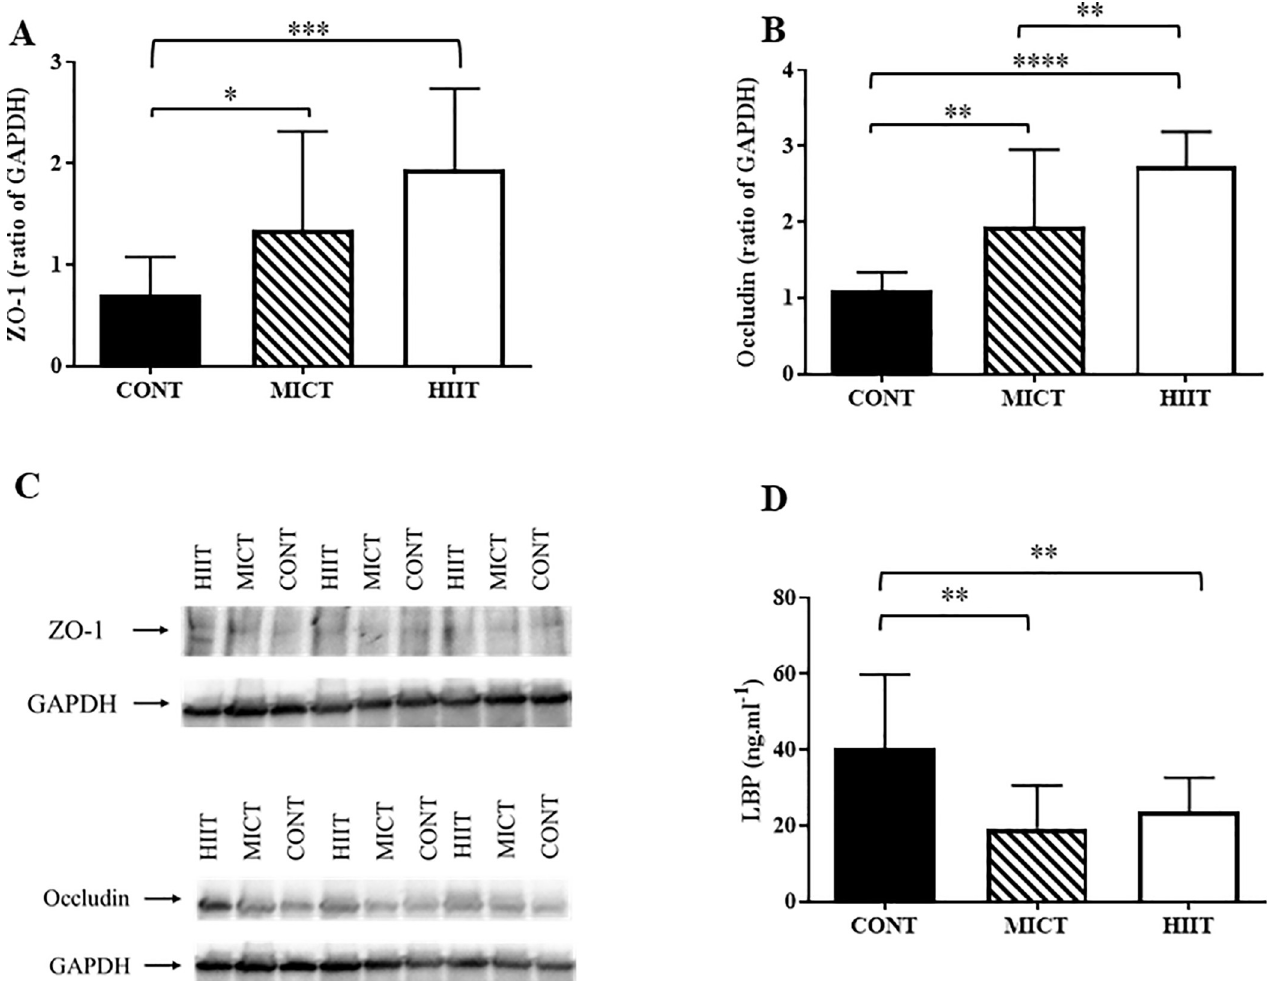
Fig 4. Effect of 10 weeks of training on intestinal permeability. Zonula occludens-1 (ZO-1) (A) and occludin (B) expression were assessed by western blotting. Representative images of the western blot results (C). Plasma levels of lipopolysaccharide binding protein (LBP) determined by ELISA (D). Data are expressed as the mean ± SD; � p � 0.05, �� p � 0.01 and ��� p �